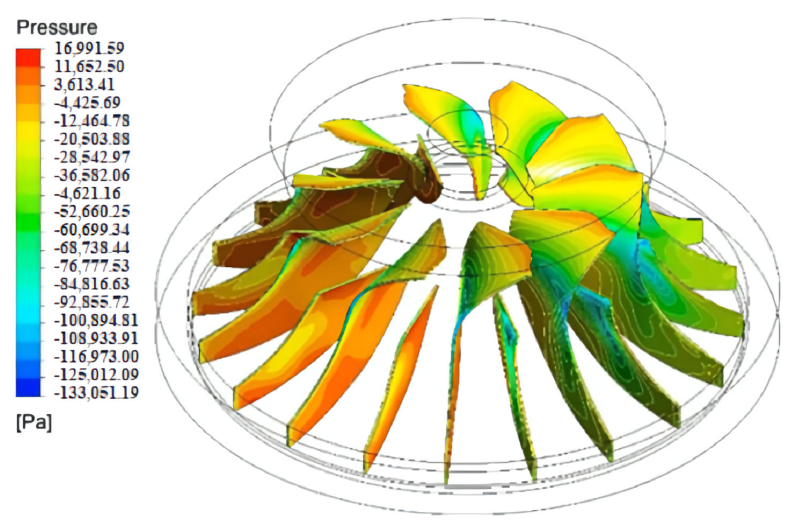
Figure 8. Pressure distribution of Type A.